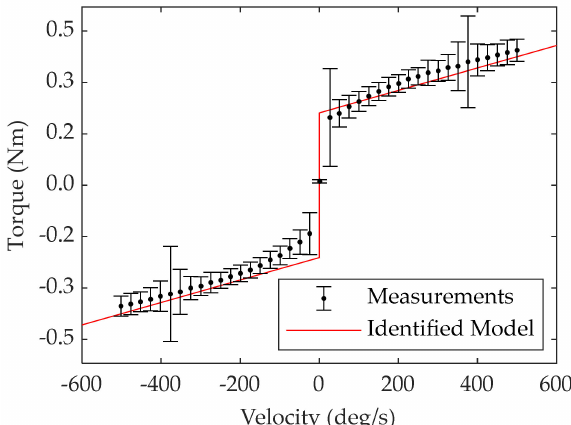
Figure 6. Measured friction levels with the actuator operating at various constant velocities. Error bars on the measured data represent one standard deviation from the mean. The identified model is superimposed, which incorporates Coulomb and viscous friction e ff